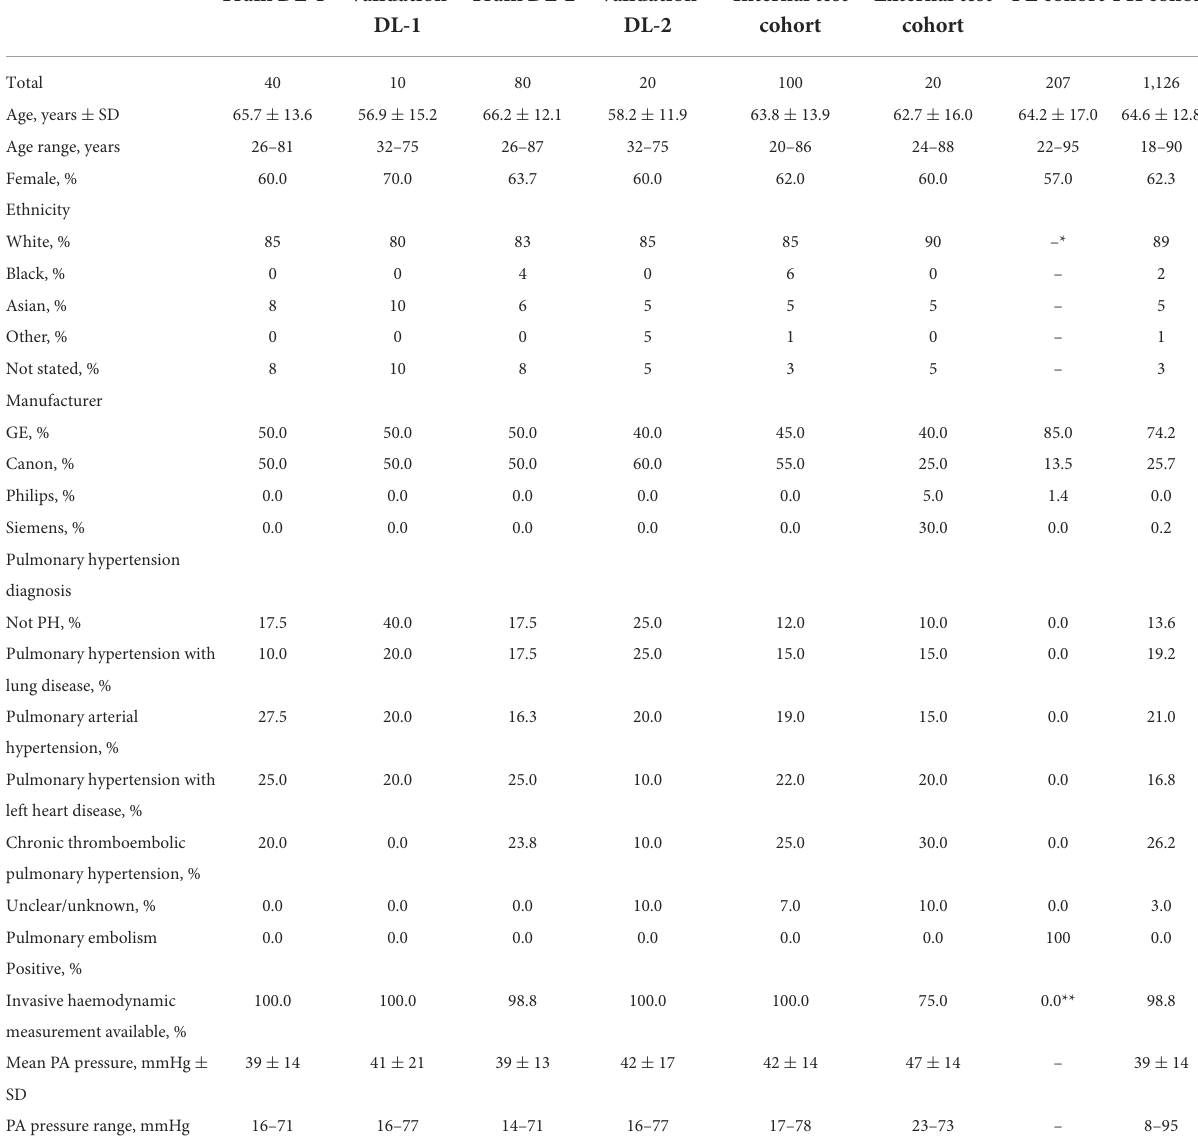
TABLE 1 Demographics, diagnosis and scanner type of the cohorts